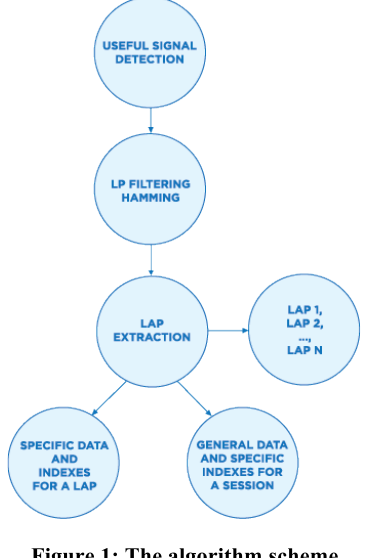
Figure 1: The algorithm scheme